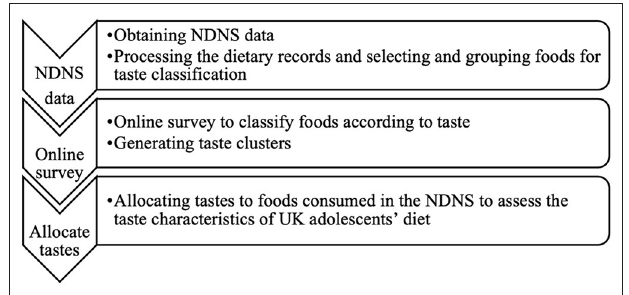
FIGURE 1 | Study outline to classify food tastes in UK